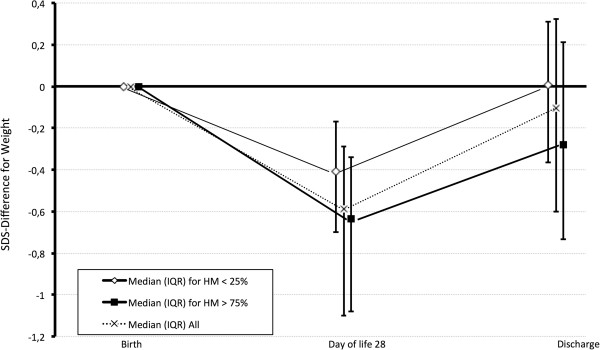
Change in SDS-differences for weight during hospitalisation (median and interquartile range). Box and whiskers is point estimate and interquartile range; horizontal line cutting y-axis in zero representing no differences in SDS for weight.